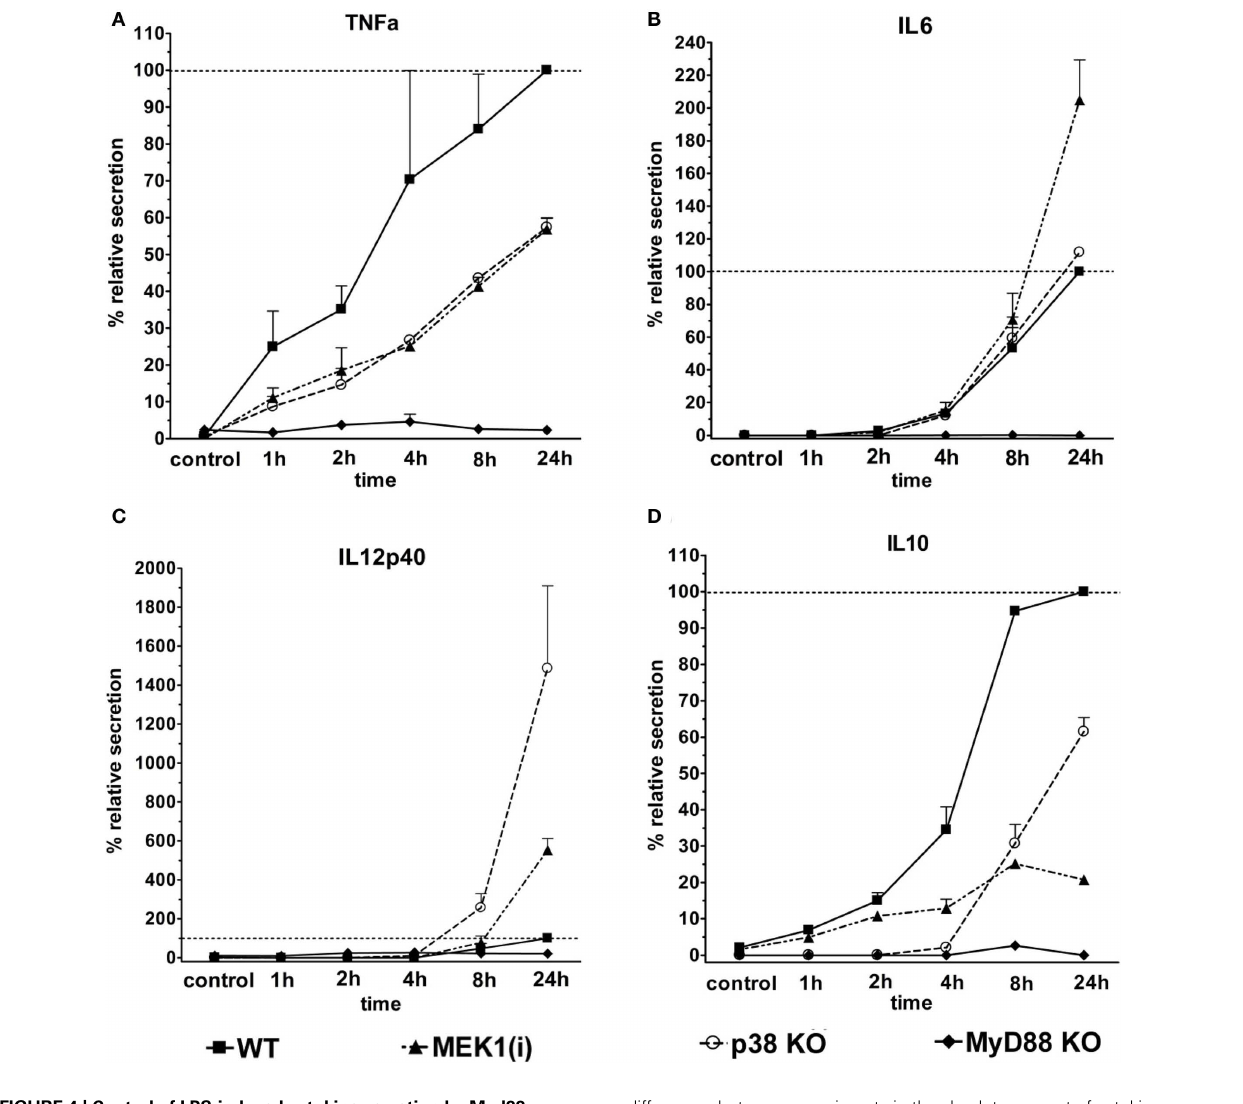
FIGURE 4 | Control of LPS-induced cytokine secretion by Myd88, ERK1/2, and p38. Supernatants of the cultures used for macrophage spreading analysis were analyzed by ELISA for the presence of the cytokinesTNF (A) , IL-6 (B) , IL-12p40 (C) , and IL-10 (D) .To normalize for